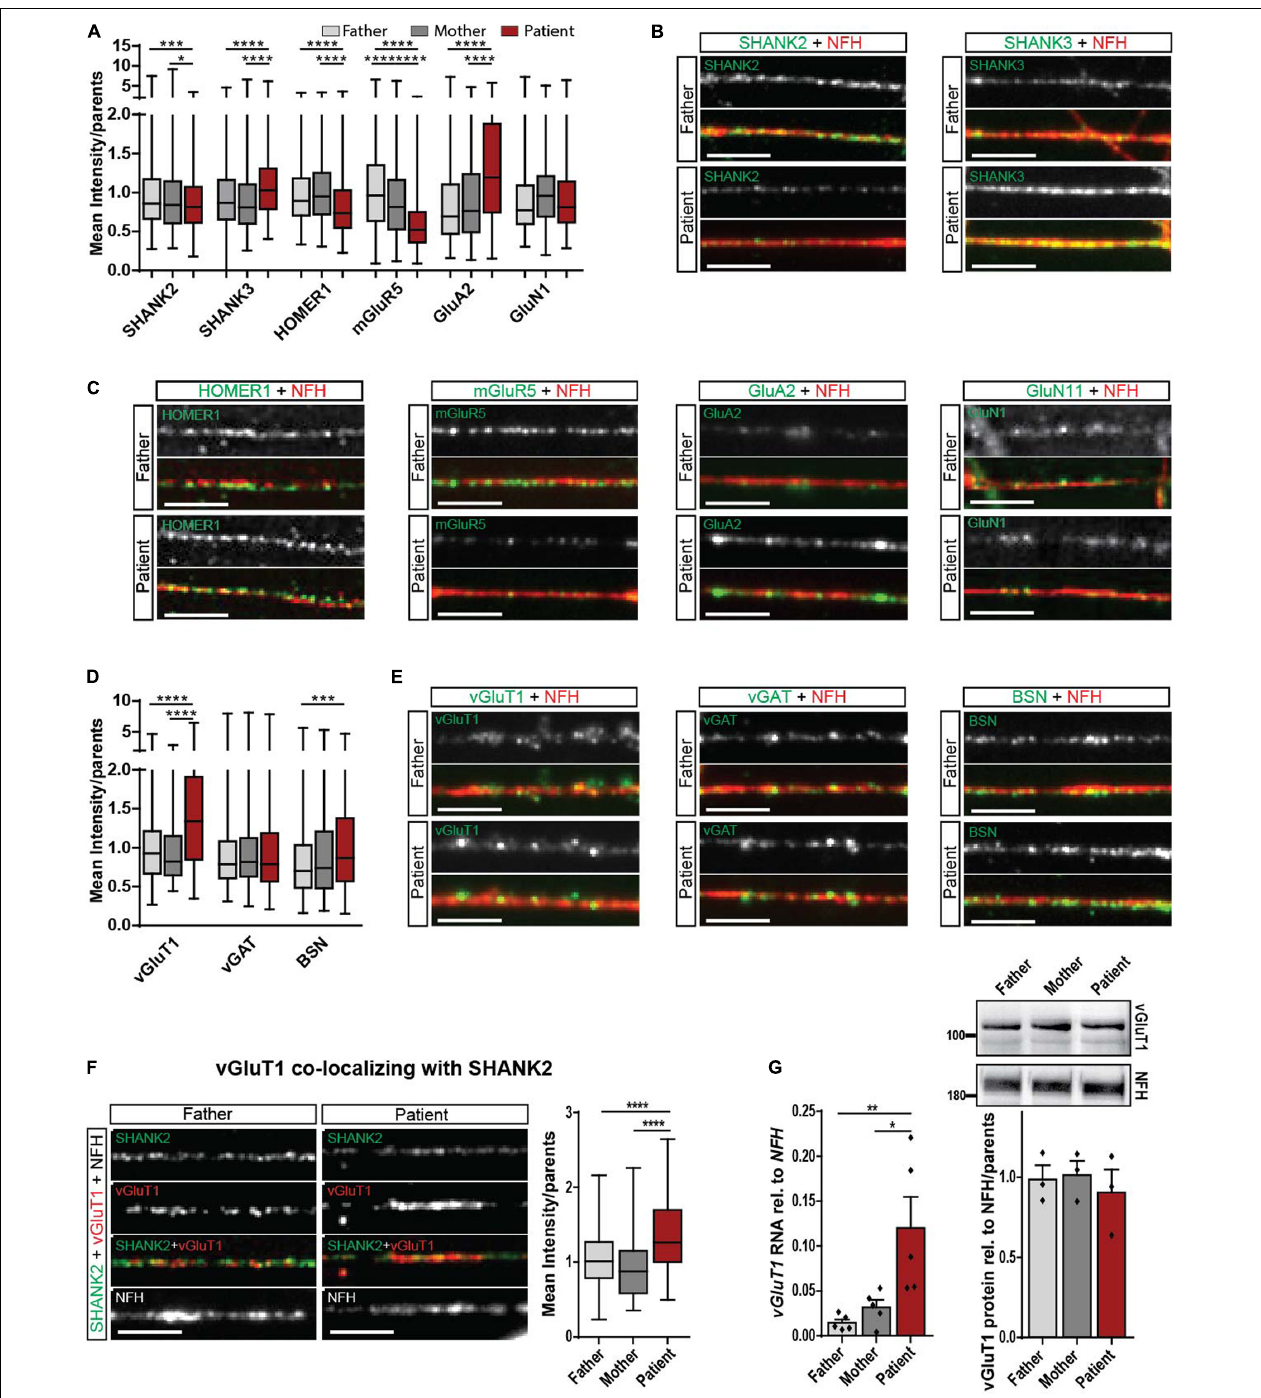
FIGURE 3 | Synaptic alteration in the patient with SHANK2 deletion in neurons d42. (A) Analysis of mean synaptic puncta intensity for SHANK2, SHANK3, HOMER1, mGluR5, GluA2, and GluN1. Data were normalized to mean of parents. (B) Representative staining for SHANK2, SHANK3, and NFH. Scale bar = 5 µ m. (C) Representative staining for HOMER1, mGluR5, GluA2, GluN1, and NFH. Scale bar = 5 µ m. (D) Analysis of mean synaptic puncta intensity for vGluT1, vGAT, and BSN. Data were normalized to mean of parents. (E) Representative staining for vGluT1, vGAT, BSN, and NFH. Scale bar = 5 µ m. (F) Staining for SHANK2, vGluT1, and NFH. Analysis of the mean intensity of vGluT1 puncta co-localizing with SHANK2. Data were normalized to mean of parents. (G) vGluT1 RNA relative to NFH ( n = 6) and vGluT1 protein levels relative to NFH ( n = 3) in neurons d42. vGluT1, vesicular glutamate transporter 1; vGAT, vesicular GABA transporter; NFH, neurofilament heavy chain; BSN, bassoon; mGluR5, metabotropic glutamate receptor 5; GluA2, AMPA receptor subunit 2; GluN1, NMDA receptor subunit 1. Box plots show the median and the distribution of the minimum to the maximum data. One-way ANOVA followed by Tukey’s post hoc analysis. Significance levels were set to * p ≤ 0.05, ** p ≤ 0.01, *** p ≤ 0.001 and **** p ≤ 0.0001.